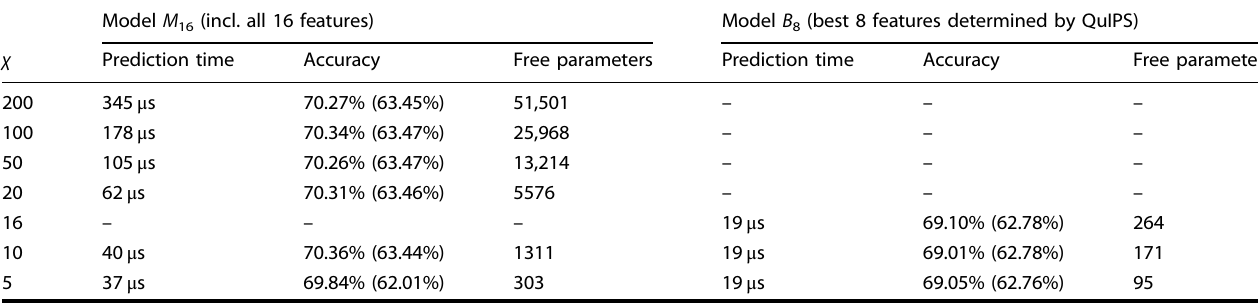
Table 1. TTN prediction